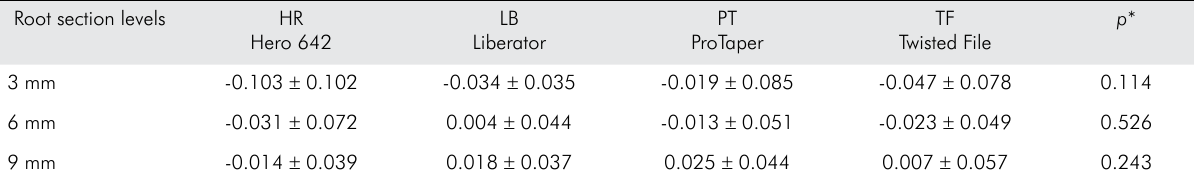
Table 1. Mean of canal transportation (mm) and standard deviation among the groups and root section levels.